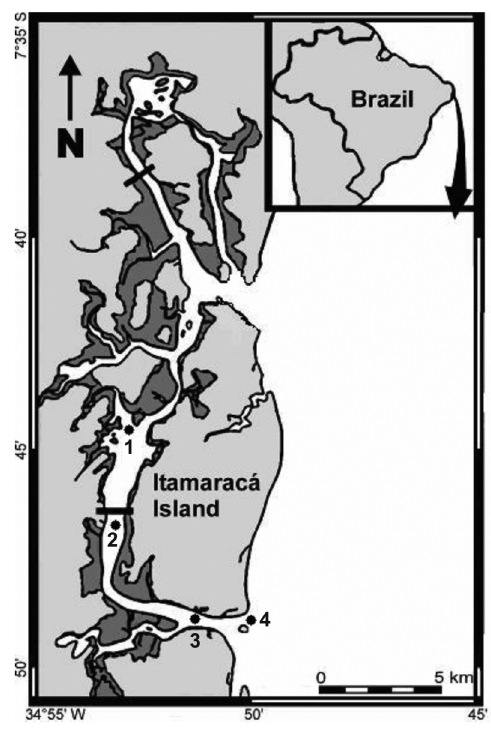
Fig. 1 – Santa Cruz Channel (SCC), with sampling stations